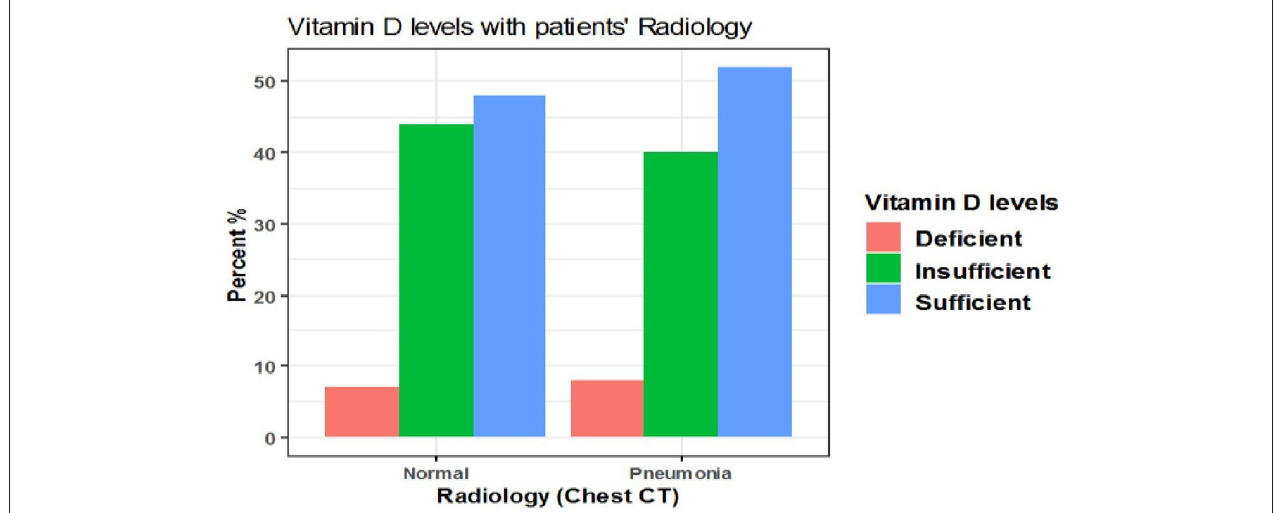
FIGURE 7 | The association between serum 25(OH)D levels (deficient, insufficient, sufficient) and radiological findings of the